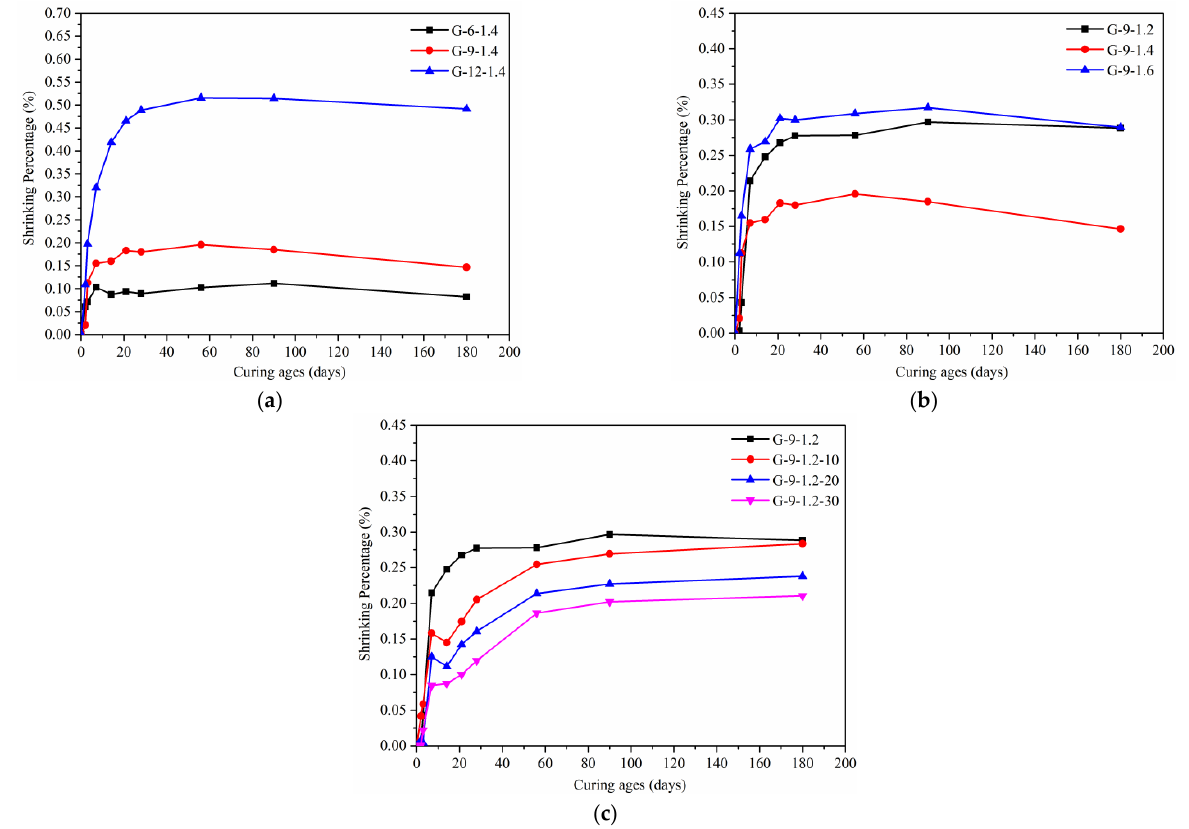
Figure 4. Influences of different factors on the drying shrinkage of FA-based geopolymer grouting materials: ( a ) content of Na 2 O; ( b ) M s ; ( c ) content of GBFS.